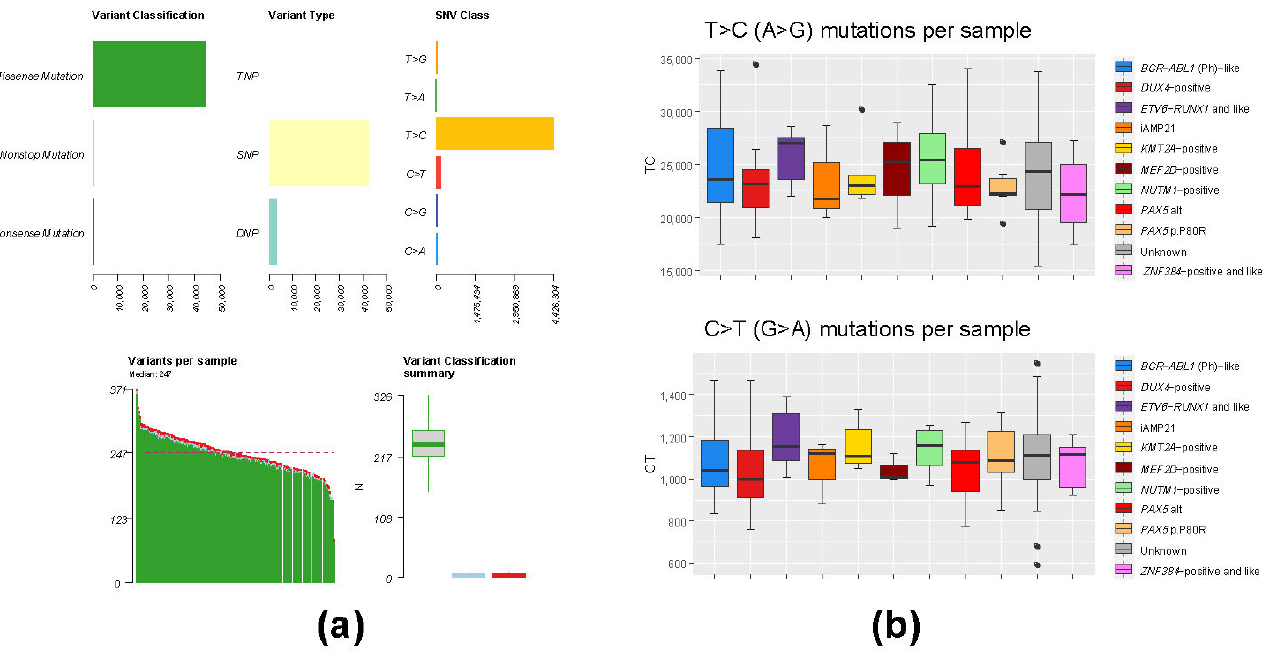
Figure 2. Mutation analysis of the entire cohort and the classified BCP-ALL subgroups does not show subgroup-specific deviation of mutation rates. The overall mutation rate statistics for the entire cohort are shown in ( a ). Median distribution of the same statistics within BCP-ALL subgroups does not show significant deviation in the number of T > C (A > G) substitutions or C > T (G > A) substitutions ( b ).